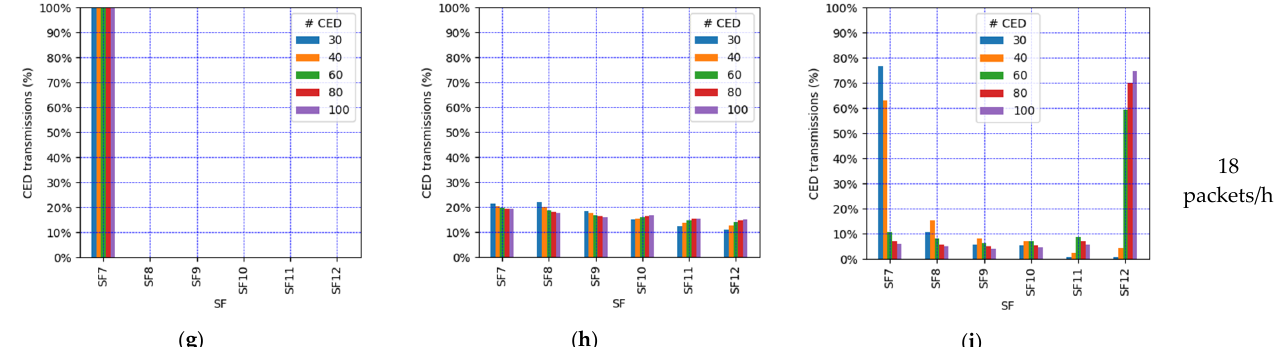
Figure 18. CED SF values distribution when SF mode is ( a , d , g ) SFM1; ( b , e , h ) SFM2; and ( c , f , i ) SFM3 and for ( a – c ) EDL equal to 0.9 packets/h, ( d – f ) 3.6 packets/h, and ( g – i ) 18 packets/h.